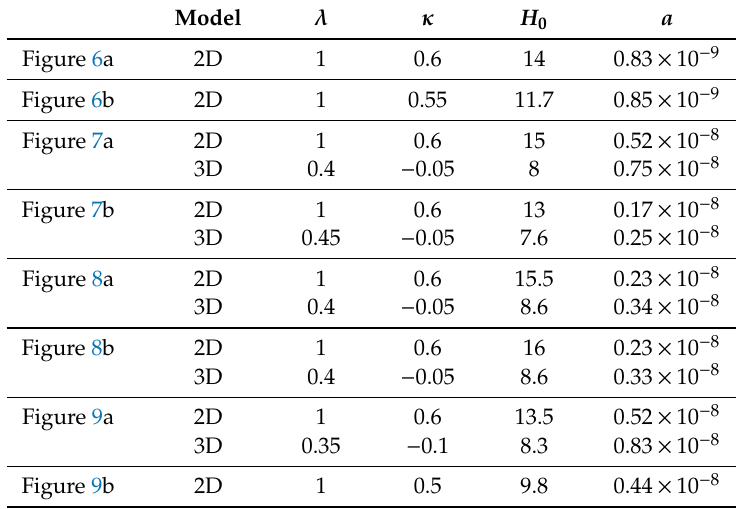
Table 1. The parameters assumed for the 2D and 3D models. The units of the parameters are λ [ β ] , κ [ β ] , H 0 [ a ](= D 0 [ a ]) and a [m], where β = 1/ k B T